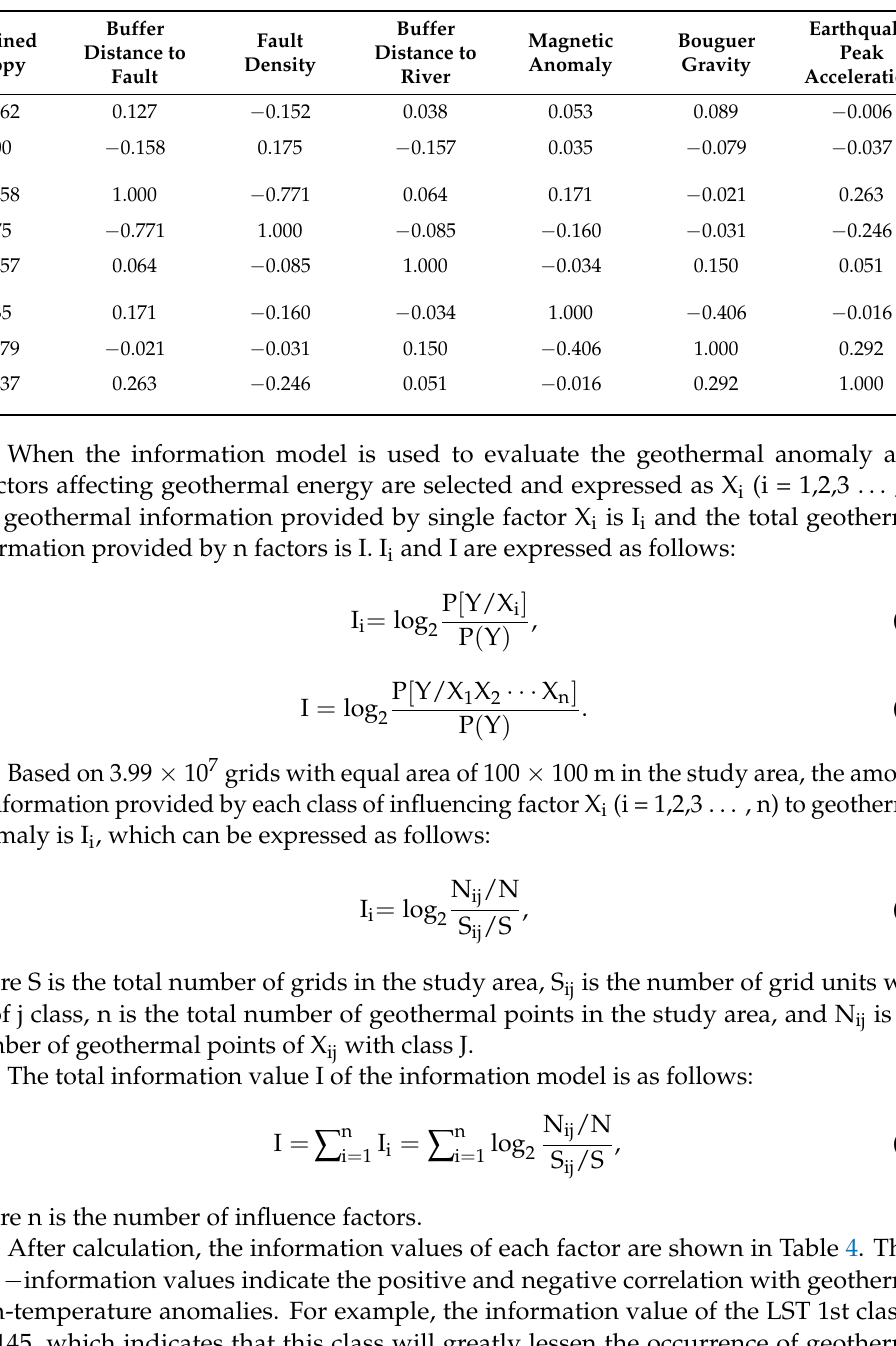
Table 3. Correlation of impact factor